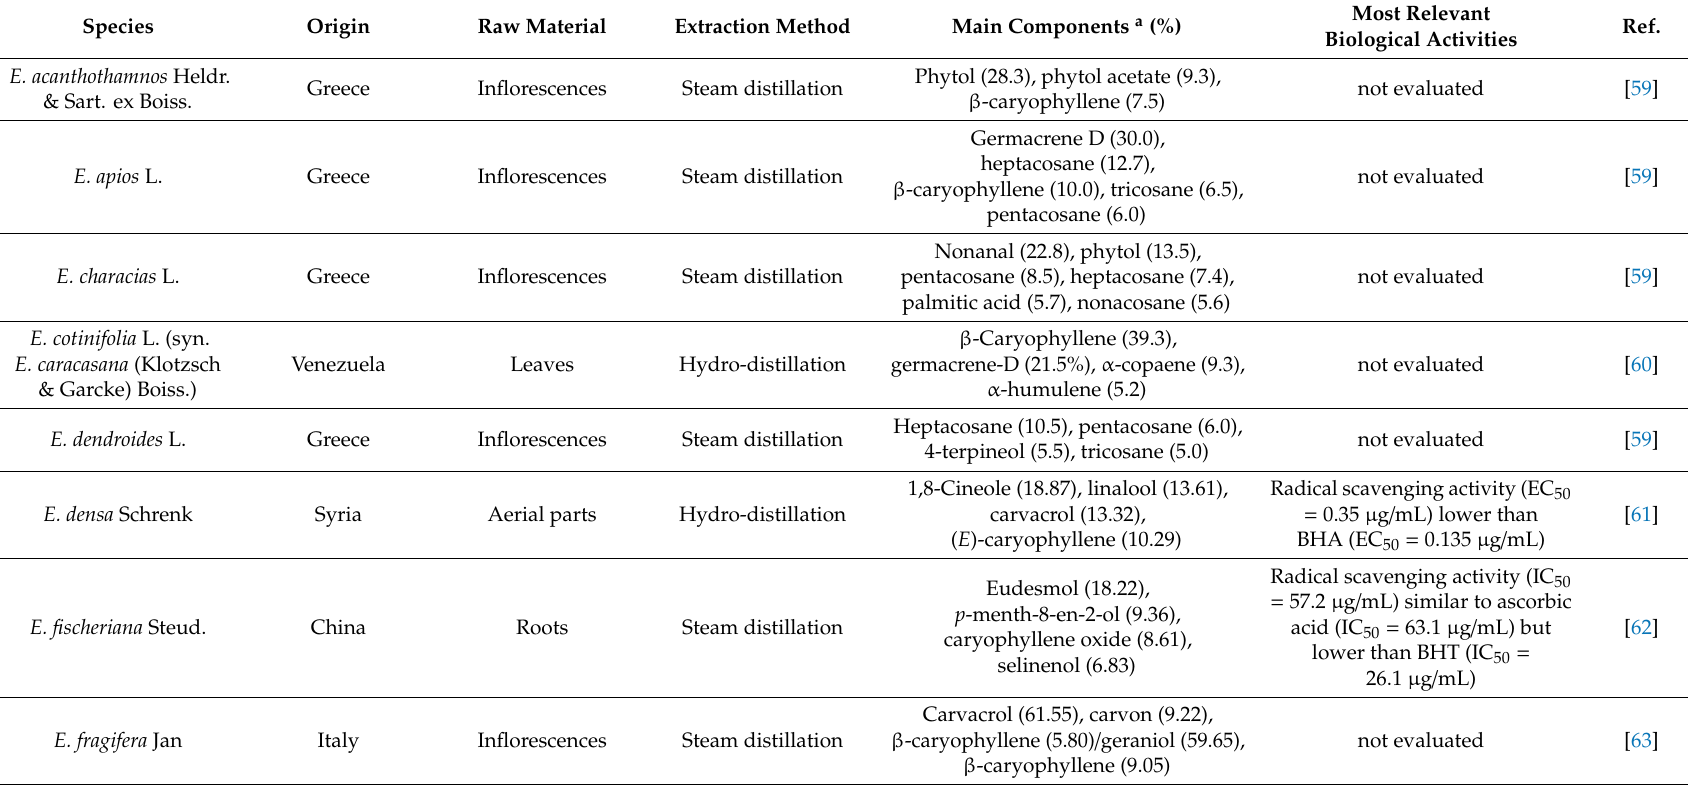
Table 1. Chemical composition and biological activities of Euphorbia essential